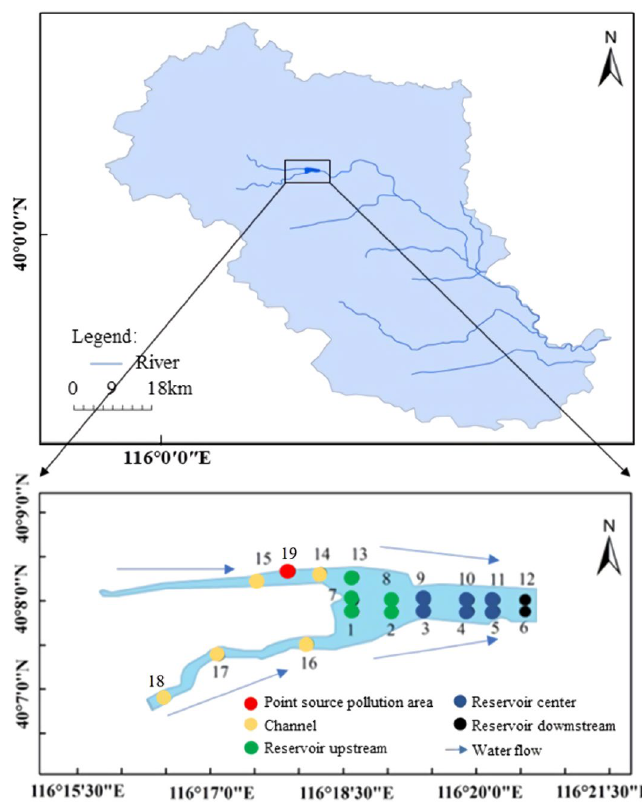
Figure 1. Arrangement and zoning map of sediment sampling points in Shahe Reservoir. (The figure was created by Wen 16 and modifed using ArcGIS sofware 10.2; Source: WGS 1984).